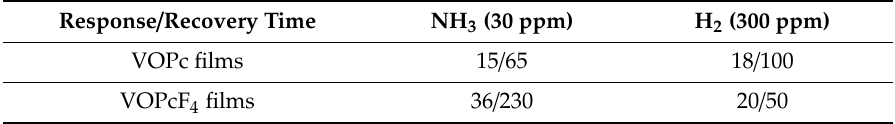
Table 1. The response and recovery time (s) of VOPc and VOPcF 4 films toward 30 ppm of ammonia and 300 ppm of hydrogen.